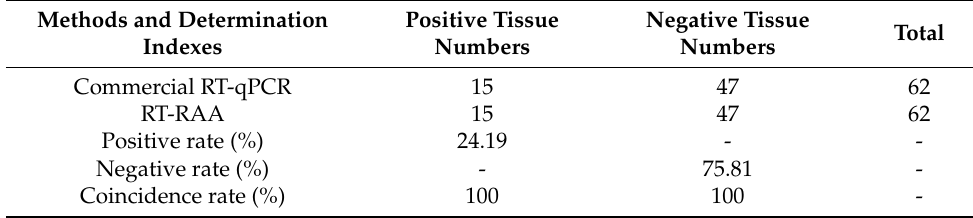
Table 4. The results of clinical